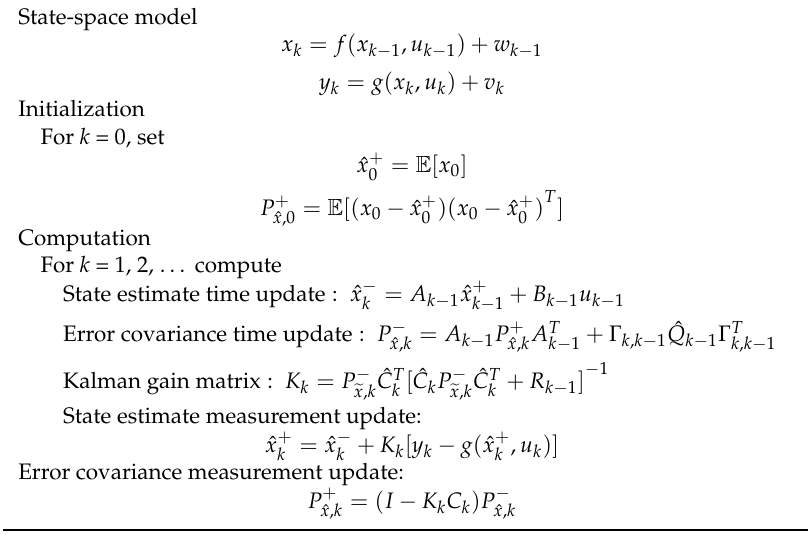
Table 10. Summary of the EKF-Ah algorithm for SOC estimation